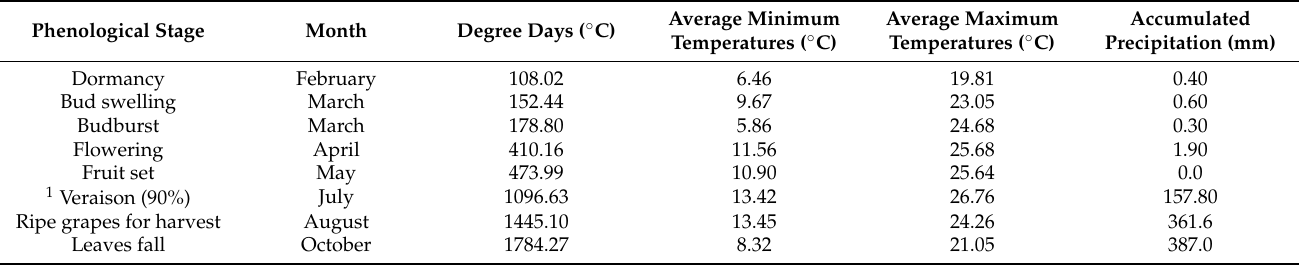
Table 1. Description of minimum and maximum temperatures and rainfall during the different phenological stages for the 2017